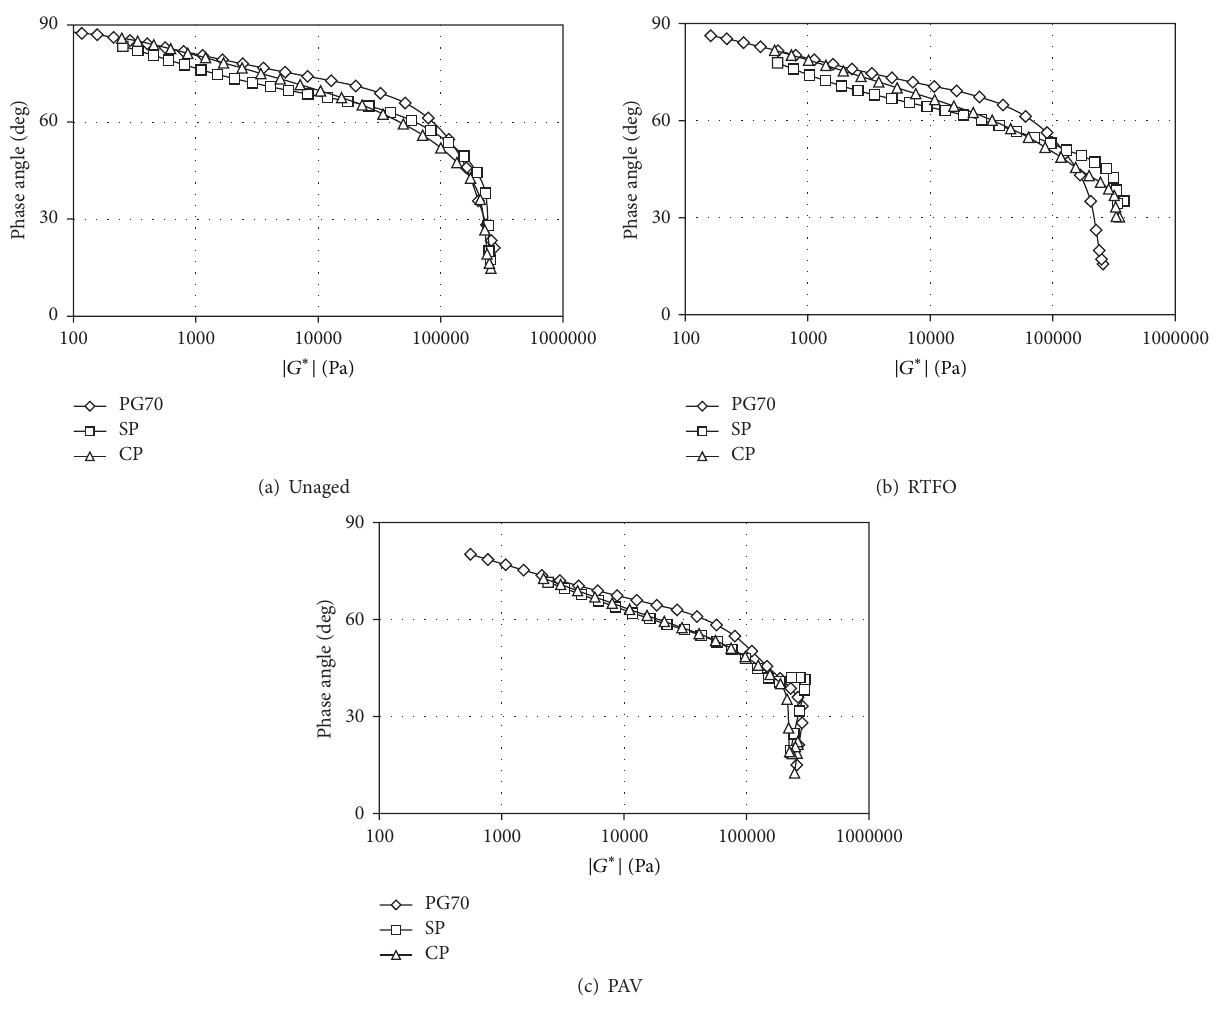
Figure 2: Black diagram for (a) unaged, (b) RTFO, and (c) PAV aged